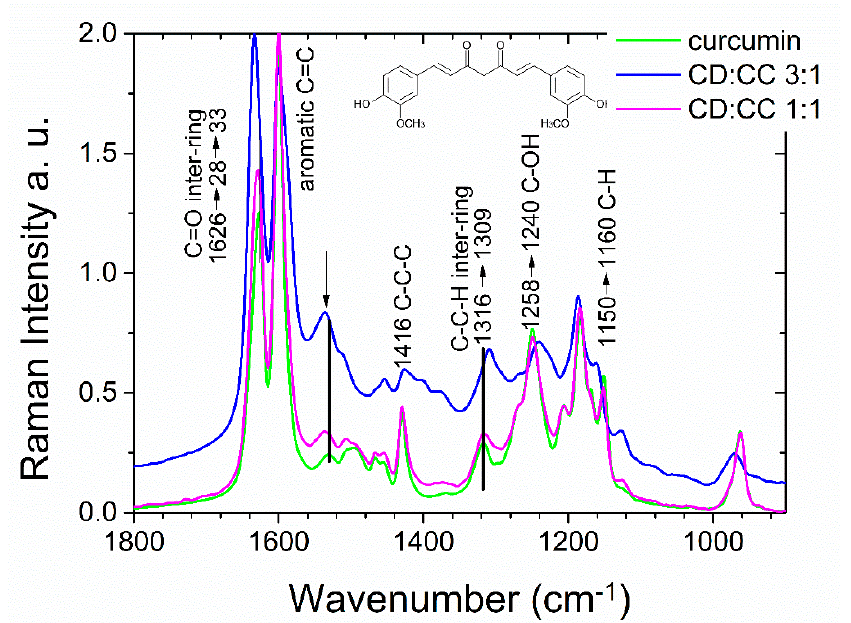
Figure 2. FT-Raman spectra of curcumin and curcumin adsorbed into CD-NP with molar ratios of CD:CC = 3:1 and 1:1. Intensities were normalized to the aromatic C=C Raman frequency at 1600 cm − 1 for better comparison.